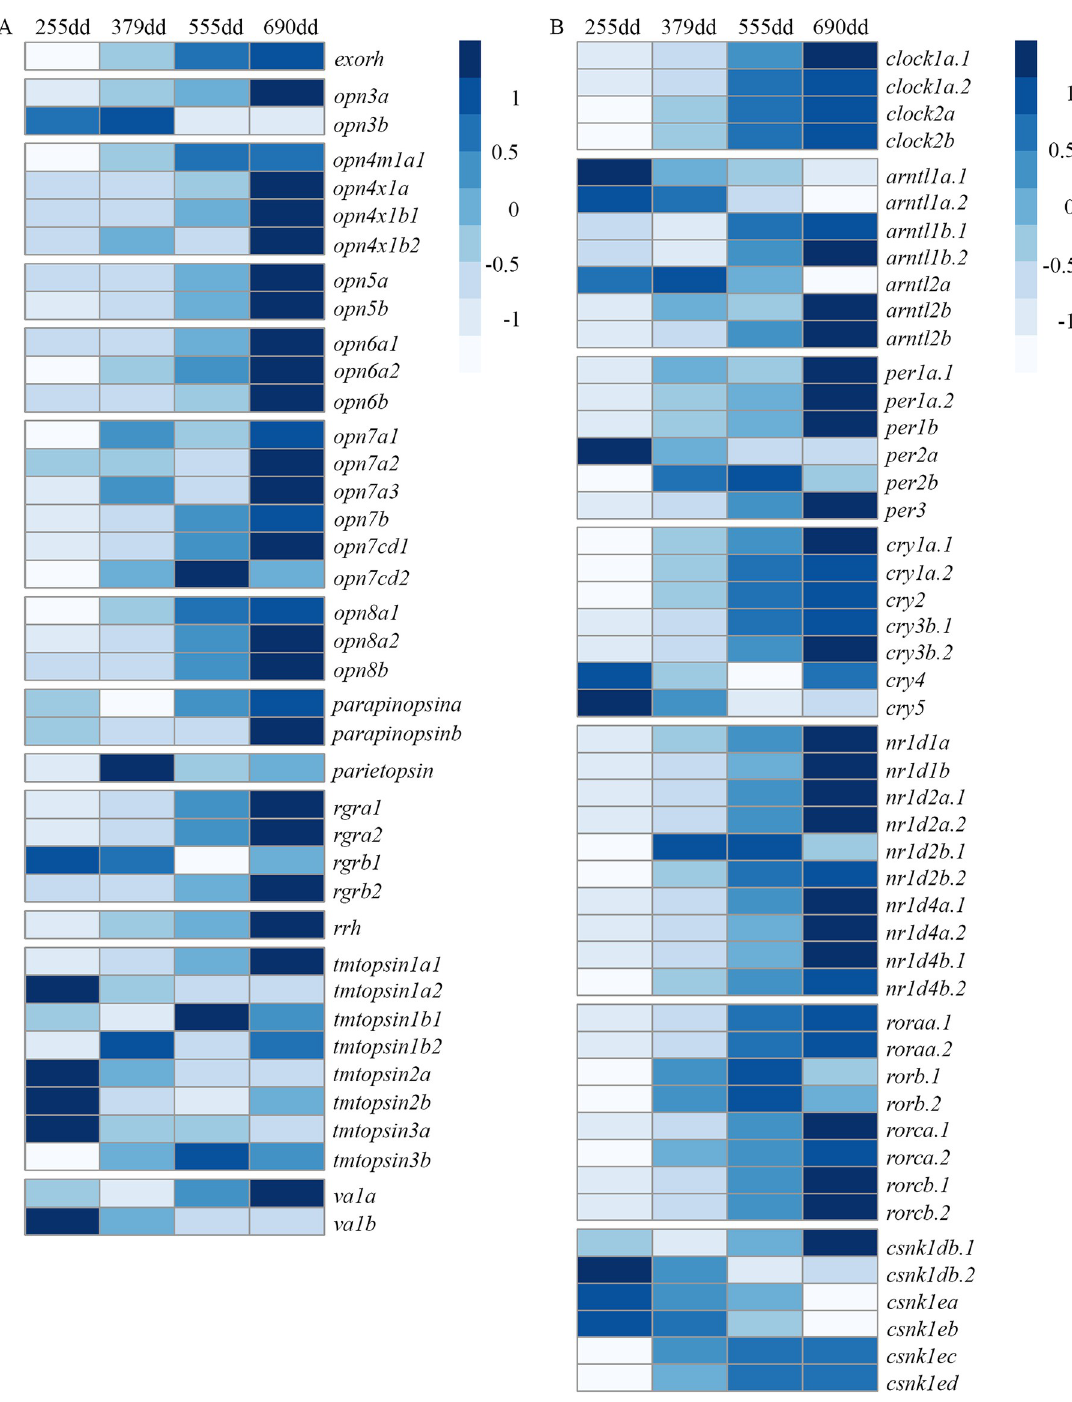
Fig 1. Heatmap of nonvisual opsins and clock genes in Atlantic salmon. The heatmap, scaled by row, shows the average normalized counts for nonvisual opsins (see S3 Table for annotations) and clock genes (see [38] for annotations) in the developmental series of embryos and alevins reared in light-dark cycles of medium intensity (LDM). Genes not expressed or not annotated at Ensembl were not included. The heatmaps show that many nonvisual opsins and clock genes are expressed early in development.